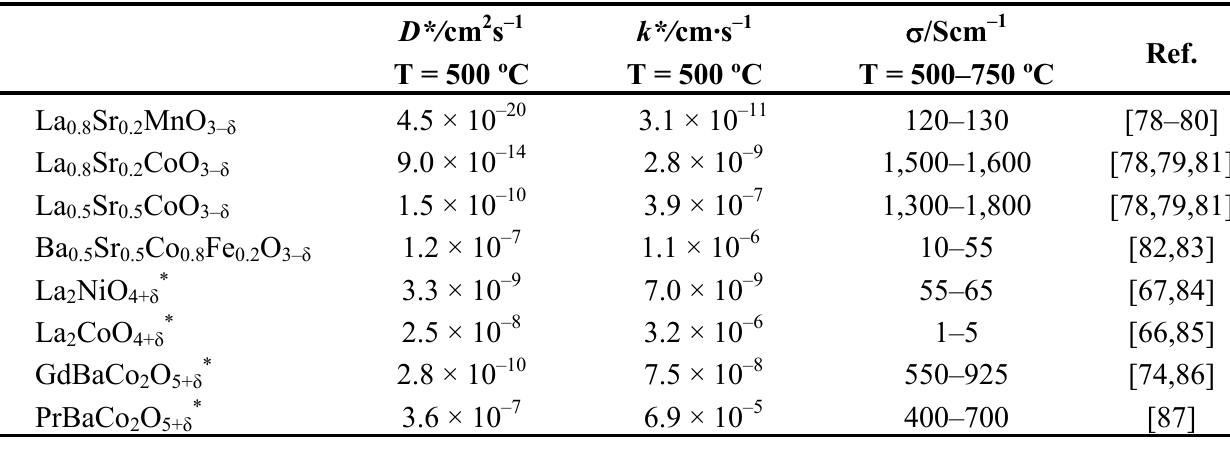
Table 2. Comparison of different values of oxygen transport properties and overall conductivity between ordered and non-ordered oxides for cathode applications in